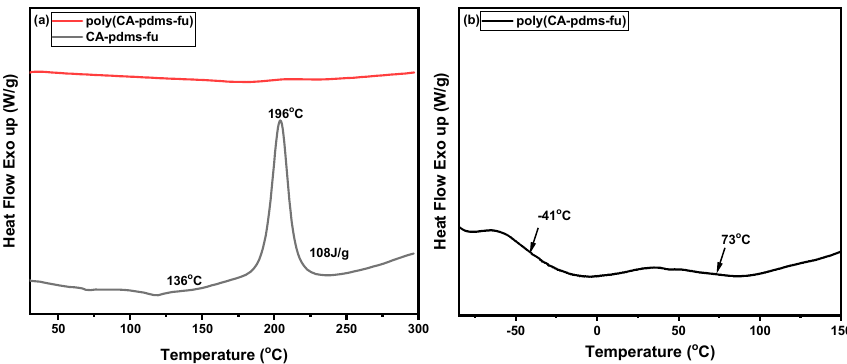
Scheme 2. Polymerization of poly(CA-pdms-fu).